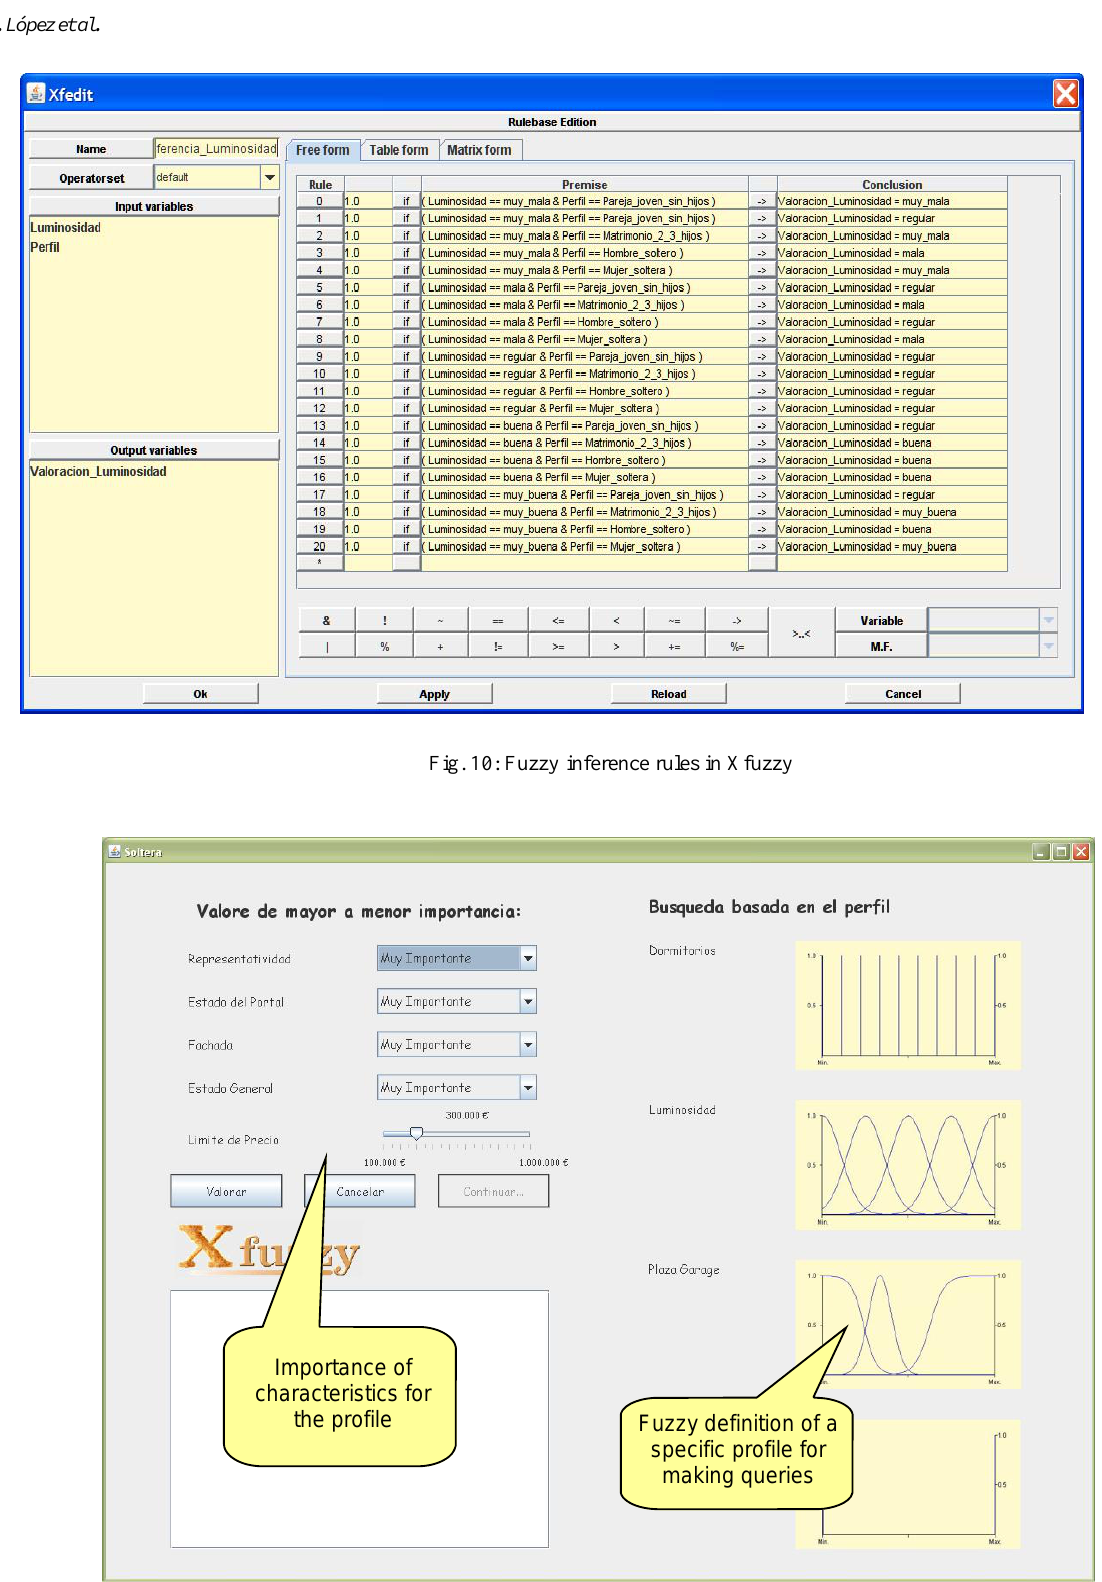
Fig. 11: Fuzzy Application for Estate